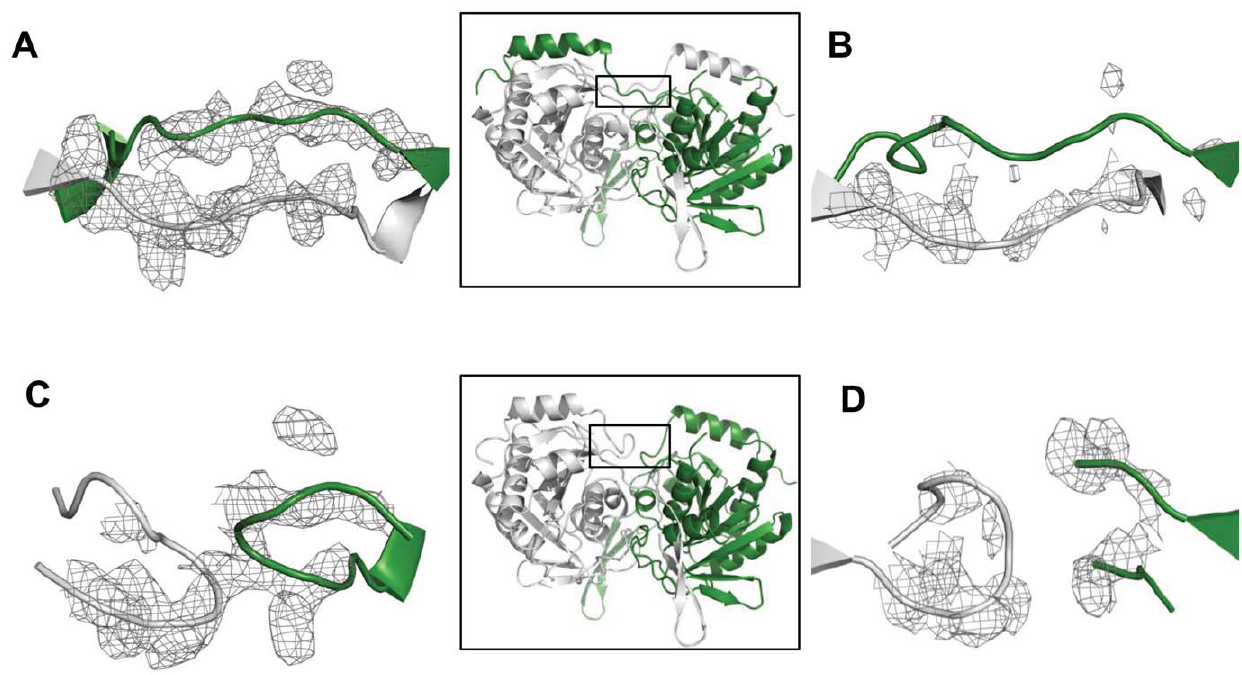
Figure 4. Fit of swapped and unswapped conformations of the hinge region to the electron density map. A) and B) show fit of swapped conformations to the electron density map (Fo-Fc; calculated after omitting the hinge region 227–231) in H234A (contoured at 3 s ) and D230A/H234A (contoured at 2.4 s ) respectively. C) and D) show fit of segments built as unswapped in H234A (contoured at 3 s ) and D230A/H234A (contoured at 2.4 s ), respectively. Color code: A chain – gray, B chain – green. In the inserts, hinge regions are boxed.